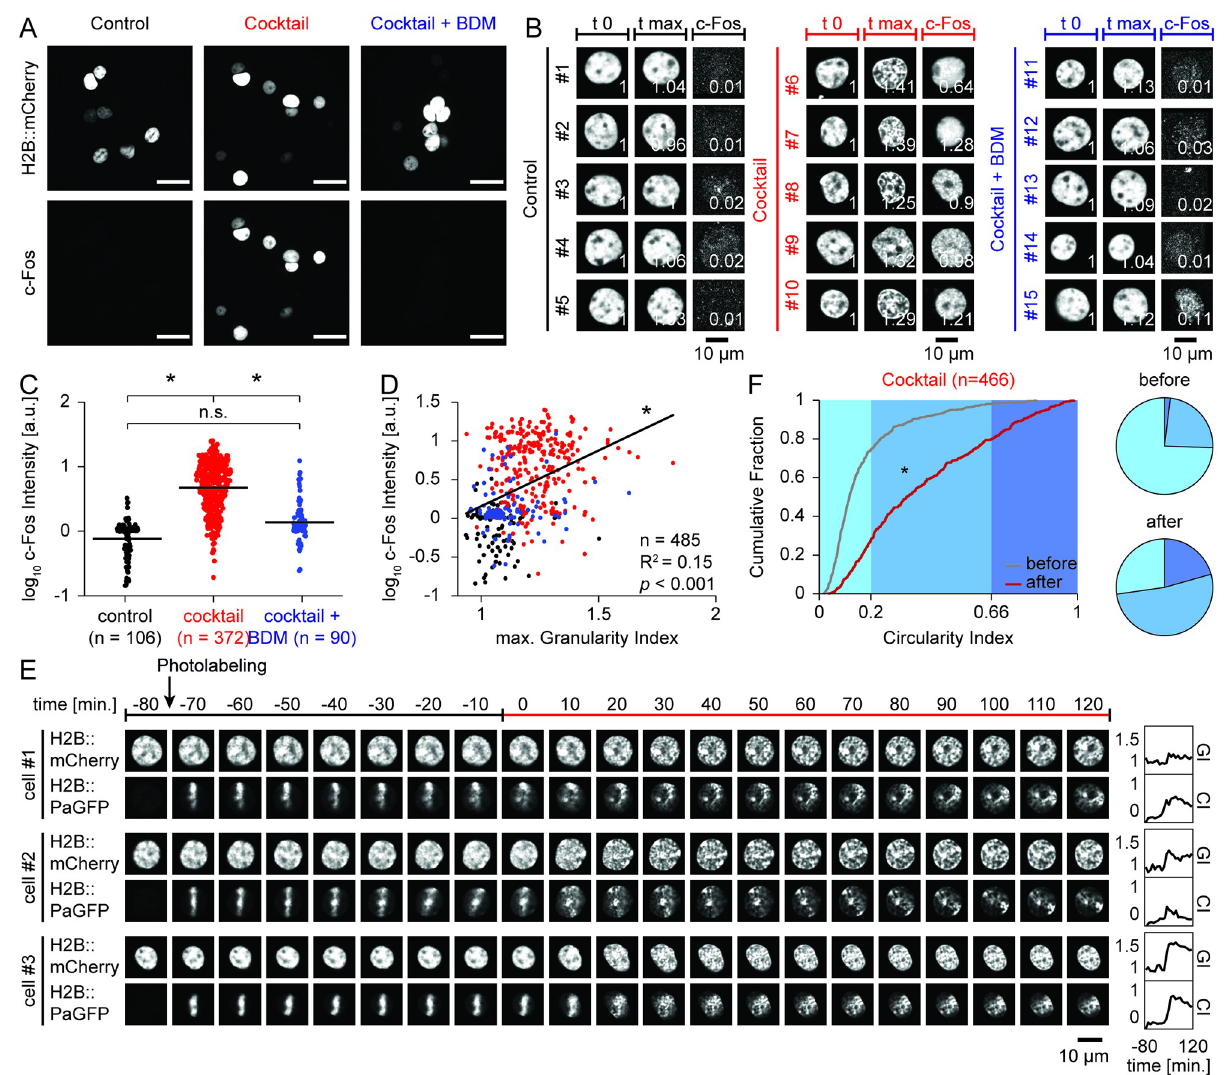
Fig 2. Reorganization of chromatin correlates with c-Fos induction and can be visualized by photolabeling of a fiducial marker. ( A ) Epifluorescence images of cultured primary cortical neurons expressing H2B::mCherry following treatment (control, cocktail, cocktail+BDM) and post-hoc immunofluorescence staining for the IEG product c-Fos. Scale bar: 25 μ m. ( B ) Confocal time-lapse imaging of the H2B::mCherry signal and post-hoc c-Fos staining for example nuclei from the three treatment conditions (control, black; cocktail, red; cocktail+BDM, blue). Shown is H2B:: mCherry signal at first time point (t 0) and time point of maximal normalized GI value (t max) during time-lapse imaging, as well as c-Fos staining after fixation. Bottom right of each image: Quantification of GI, or log 10 c-Fos intensity, respectively. ( C ) Dot plot of log 10 c-Fos intensity of all individual cells from the three treatment conditions (control, black; cocktail, red; cocktail+BDM, blue; horizontal lines indicate mean). ( D ) Scatter plot of maximal normalized GI value during time-lapse imaging and corresponding post-hoc log 10 c-Fos intensity of individual cells. (control, black; cocktail, red; cocktail+BDM, blue; black line: Linear fit). ( E ) Confocal time-lapse images of example nuclei co-expressing H2B::mCherry and H2B::PaGFP before and after incubation with pharmacological cocktail inducing neuronal activity. Top: Arrow indicates photolabeling time point, colored line indicates treatment period. Right: Corresponding quantification of normalized GI and CI values over time. ( F ) Cumulative distribution of CI values from all cells. Curves depict CI value of each cell before (t -10; gray) and maximal CI value after time point of drug application (t 0 –t 120; red). Bottom: Corresponding pie chart